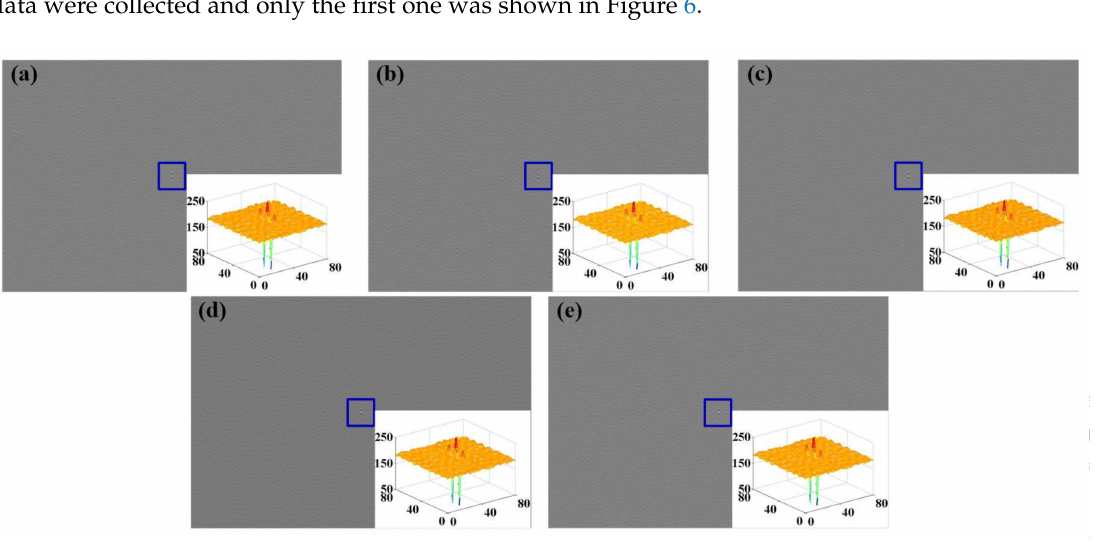
Figure 6. Interferograms of test gases ( a ) NO 2 ( b ) SO 2 ( c ) NO 2 + SO 2 ( d ) C 6 H 6 ( e ) C 7 H 8